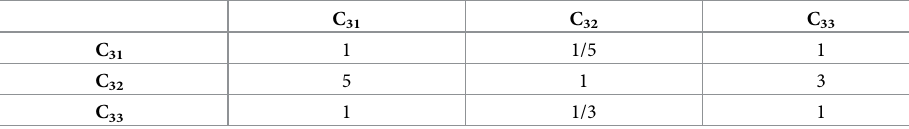
Table 7. Pair-wise comparisons of group factors.